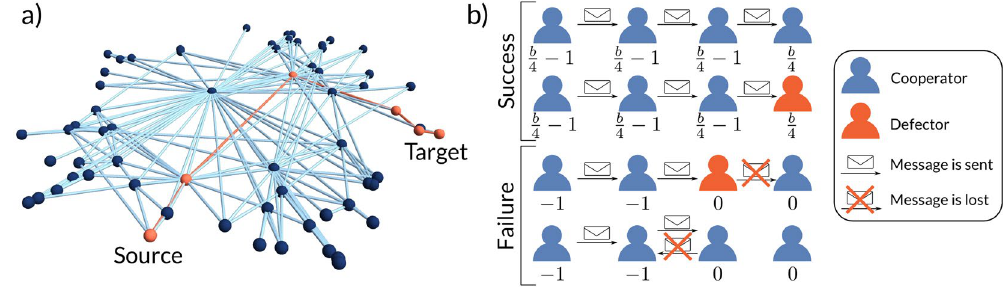
Figure 1. ( a ) Illustration of a message forwarding path found by greedy routing. Nodes and edges on the path are highlighted. (b) Illustration of the different possible scenarios of message forwarding events. In the first two cases, the message is delivered successfully. Each node obtains a share of the generated value b and those that forwarded the message pay the cost of 1. Here, we have four nodes involved (including the final recipient), and hence each node obtains the share b /4. The state of the final destination has no impact, as a defector will also happily receive her message. In the third and fourth case the delivery fails. In the third case the message is given to a defector along the chain which simply does not forward the message. In the fourth case, although all nodes cooperate, the message runs into a loop and the delivery also fails, which is a property of the classical greedy routing procedure. In the third and fourth case, there is no reward, and each node that has sent the message to a neighbor pays the cost of 1 (i.e. a payoff of −